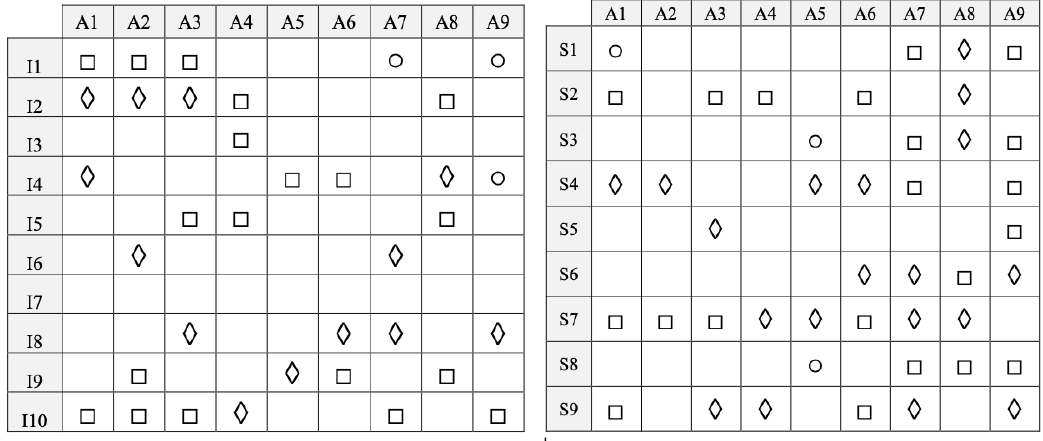
Figure 3. Two-dimensional relationship matrix that points to the convergence between Urban Agriculture and (a) Industry 4.0, as well as (b) Society 5.0. Source: Authors